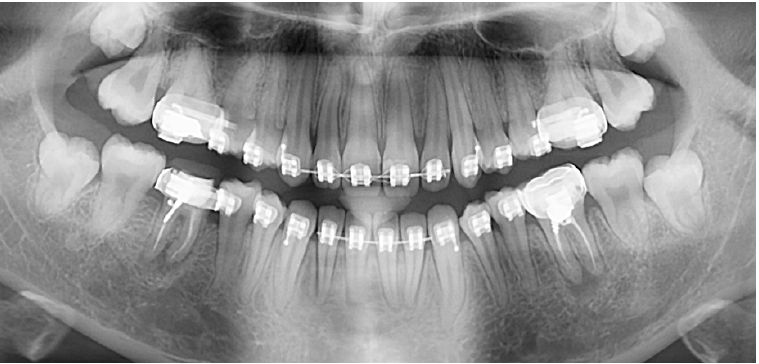
Figure 4. Clinical challenges that taurodont teeth posed for the general practitioner.